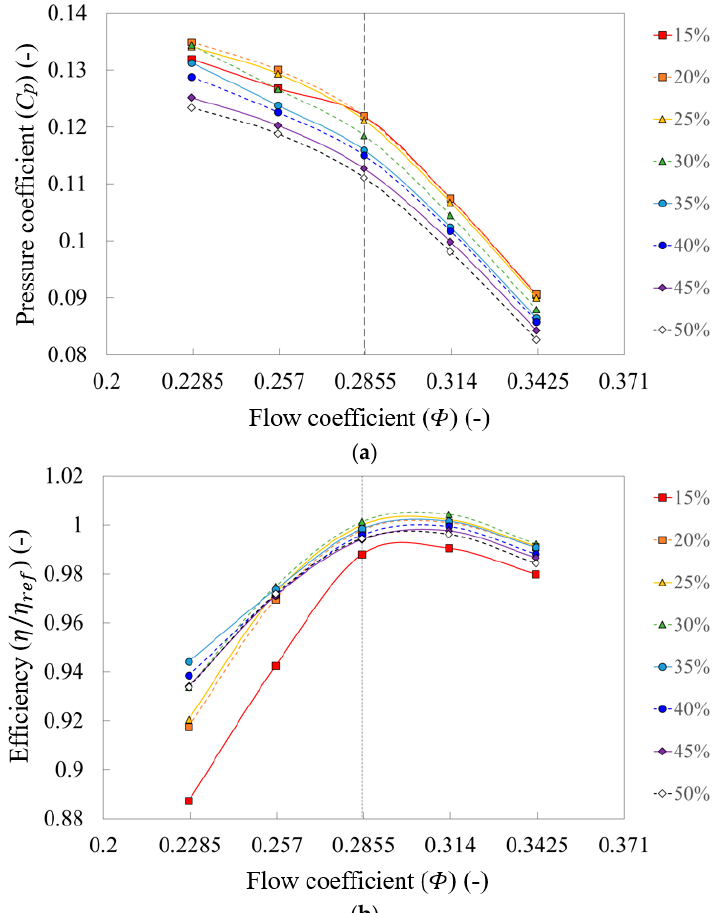
Figure 9. Performance curves with different maximum thickness positions ( Φ / Φ des = 0.8–1.2): ( a ) total pressure; ( b ) efficiency.